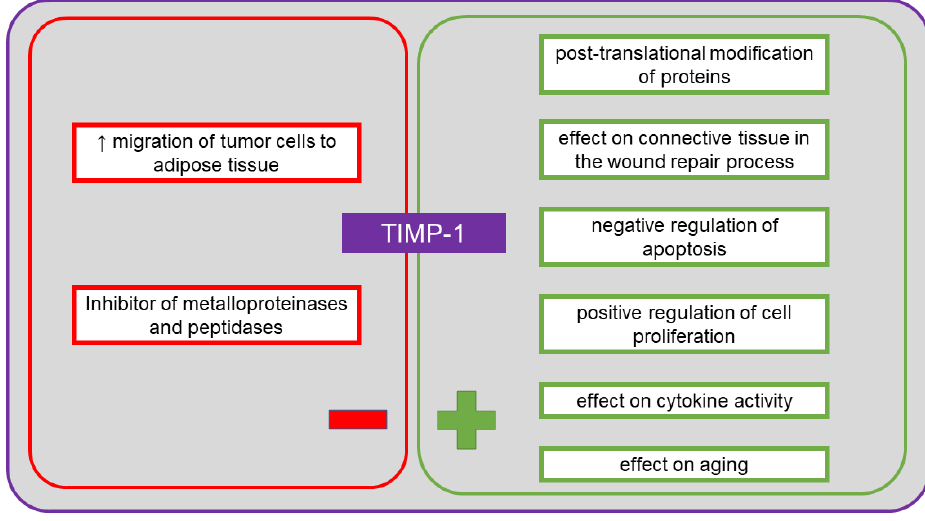
Figure 6. The positive and the negative systemic effects of tissue inhibitor of metalloproteinase-1 (TIMP-1).